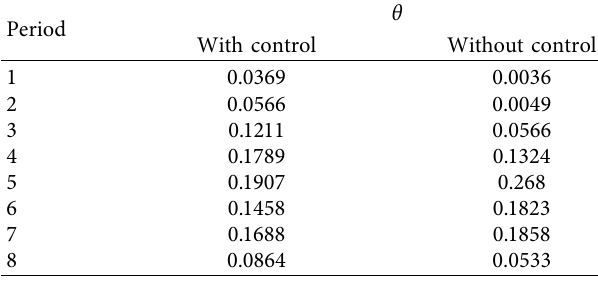
Table 10: Equalization coefficients of boarding ratios.